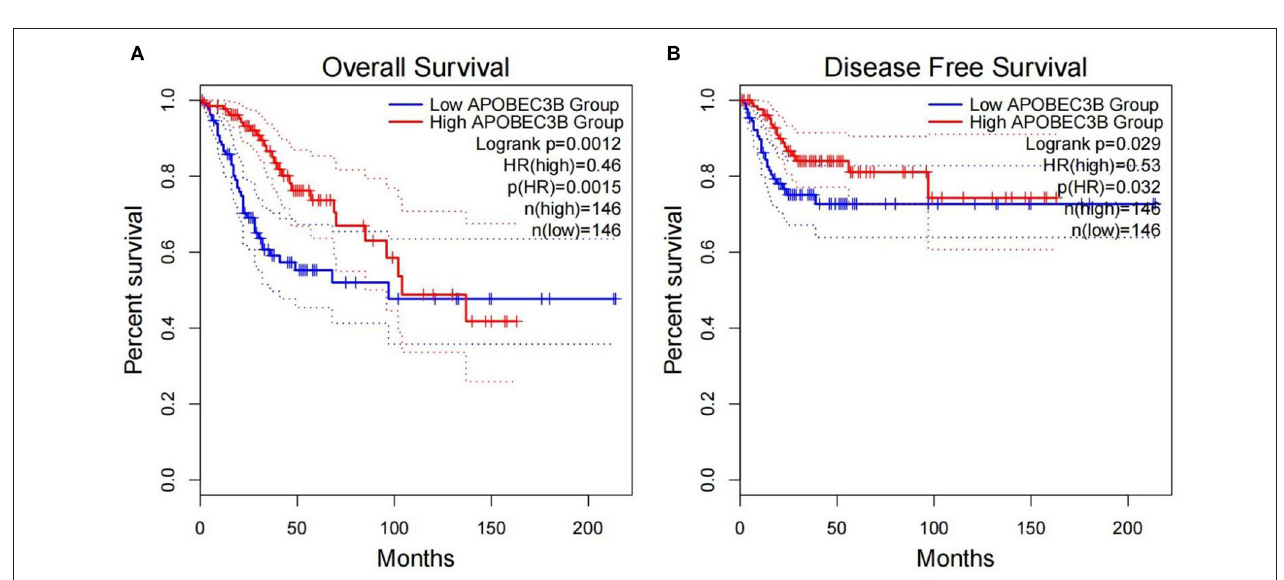
FIGURE 7 | Correlation between the expression of APOBEC3B and overall survival (OS) and disease-free survival (DFS). (A) Overall survival was inferior in APOBEC3B -low patients; (B) DFS was inferior in APOBEC3B -low patients.